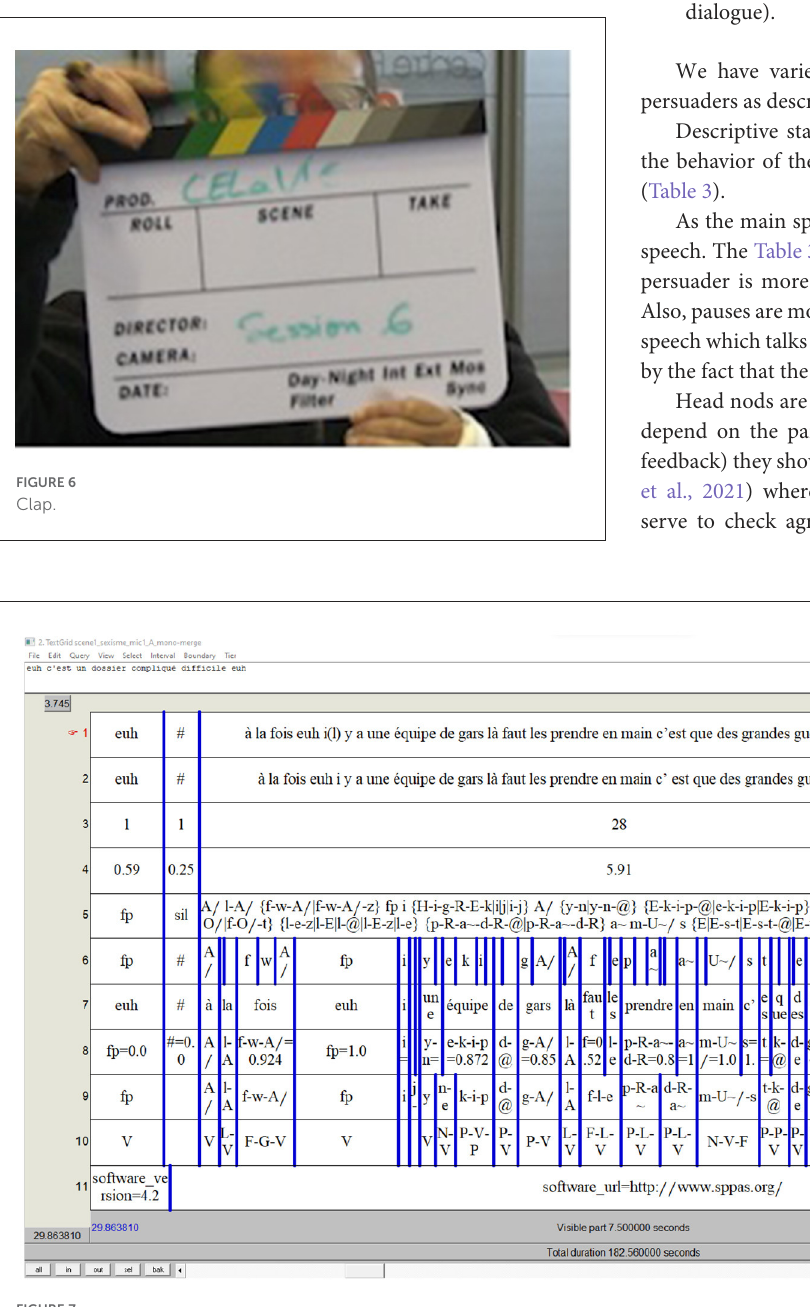
FIGURE7 Screenshot of the SPPAS tool for the segmentation and correction of the